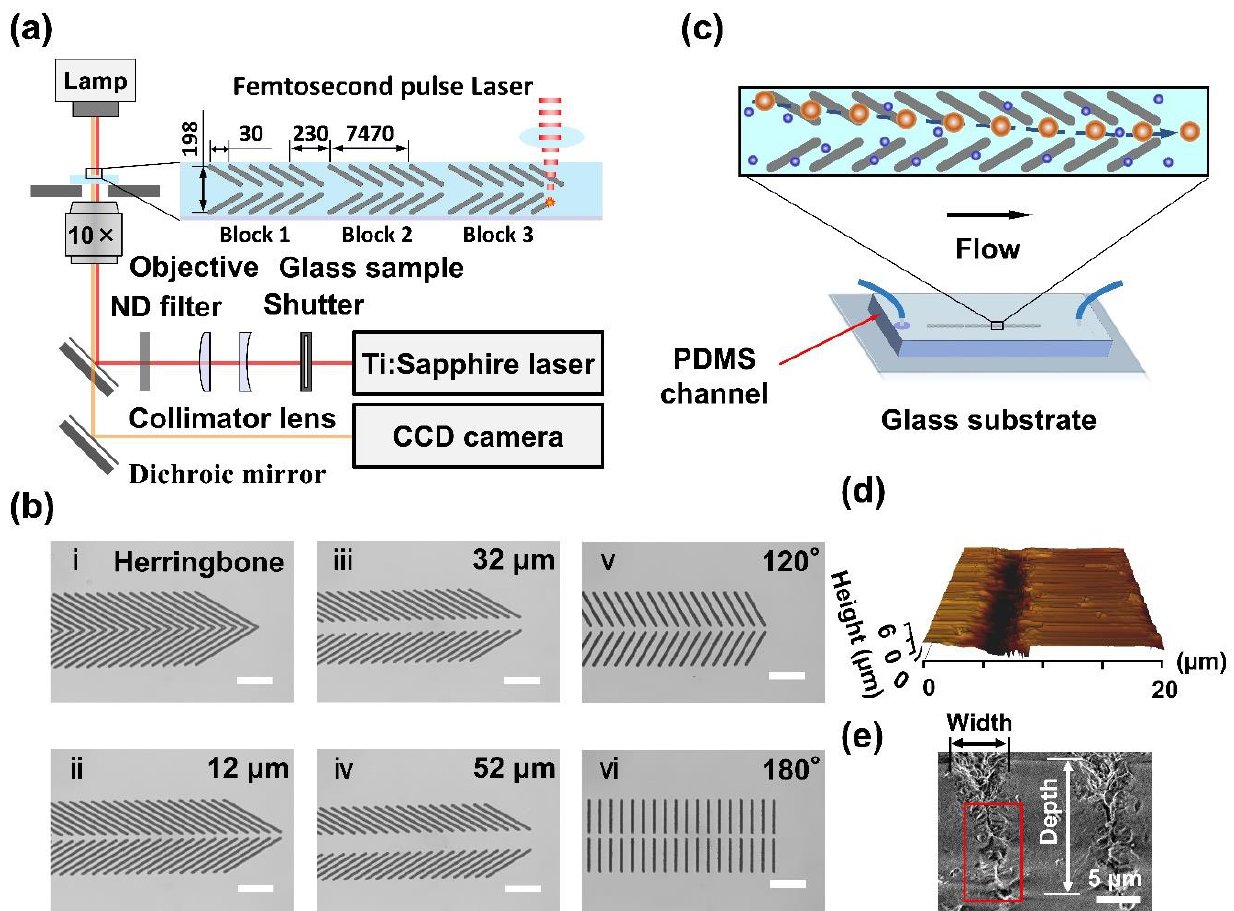
Figure 1. Femtosecond pulse laser engraved glass surface microstructures for selective particle focusing in a microchannel. ( a ) Schematic illustration of the laser fabrication system. ( b ) Six engraved microstructures of grooves: ( i ) herringbone, ( ii – iv ) 60 ◦ open v-shaped grooves with middle open spaces of ~12, 32 and 52 µ m, and ( v – vi ) 120 ◦ and 180 ◦ open v-shaped with a middle open space of ~12 µ m. Scale bar is 90 µ m. ( c ) Schematic illustration of the microfluidic device used for selective particle focusing. ( d ) A 20 × 20- µ m typical AFM image of the groove structure. ( e ) An SEM image of bird’s-eye view of the groove engraved by fs laser at 3.3 µJ/pulse.